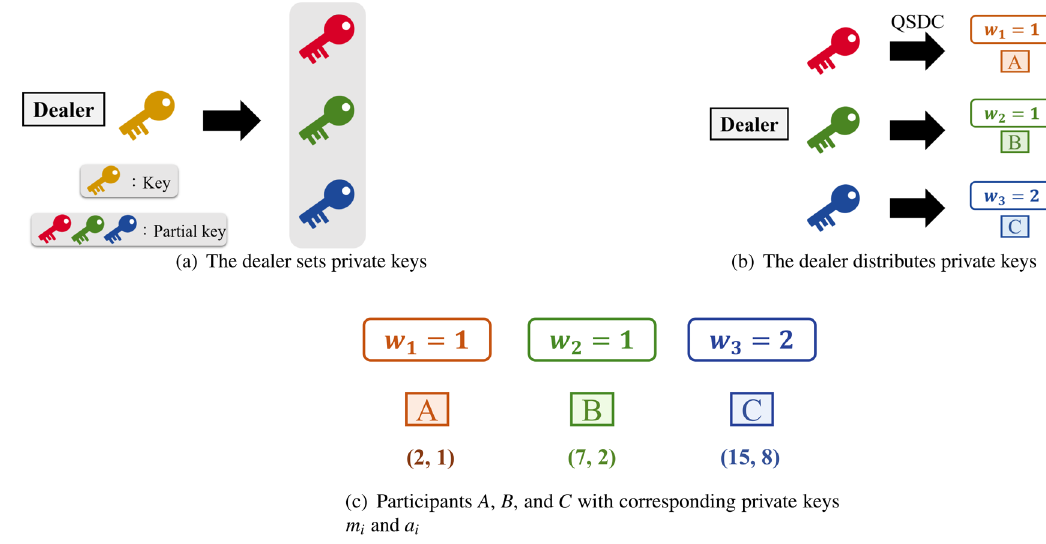
Figure 1. The dealer distributes private keys.